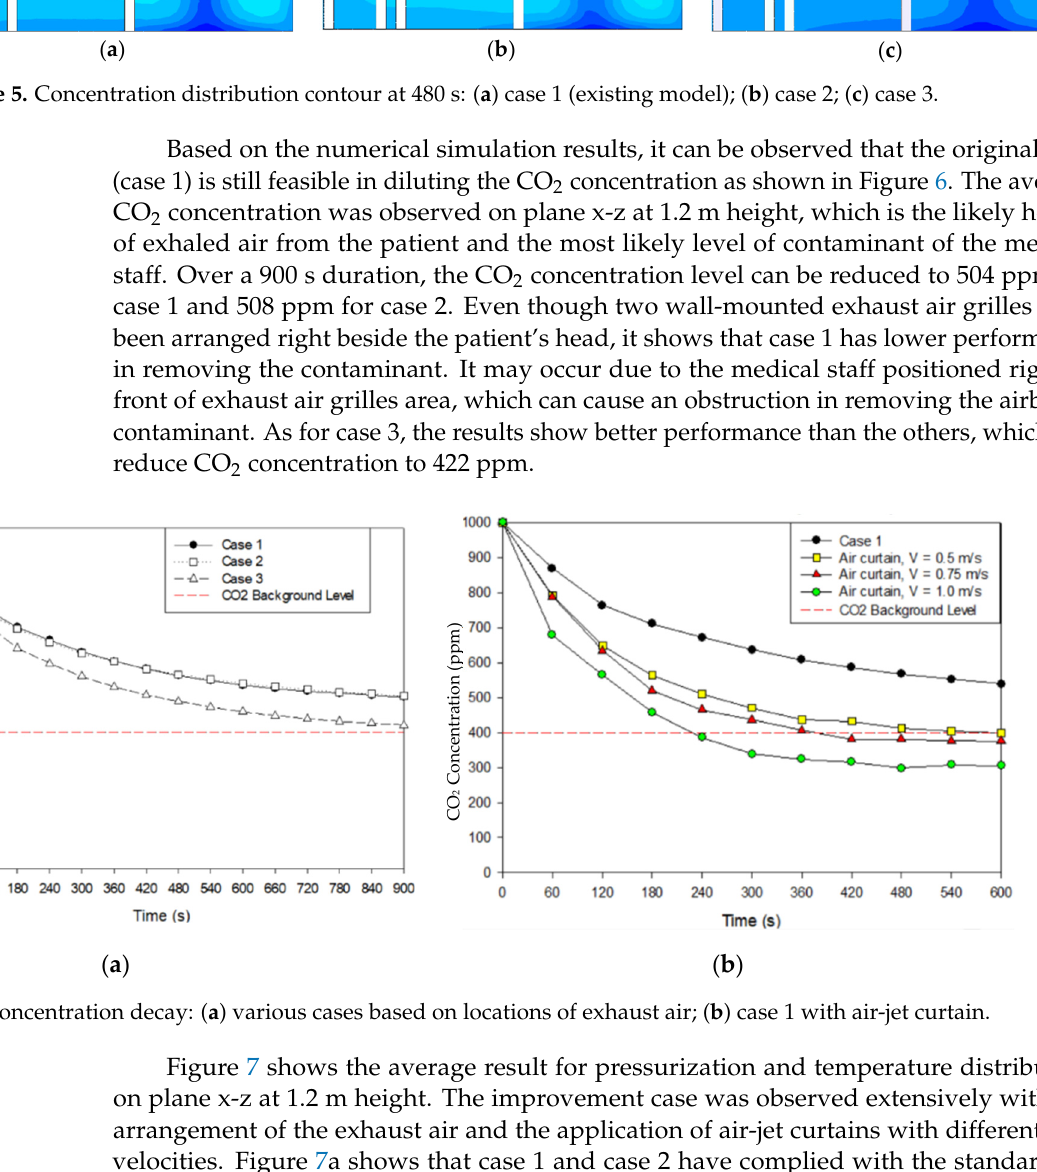
Figure 5. Concentration distribution contour at 480 s: ( a ) case 1 (existing model); ( b ) case 2; ( c ) case 3.